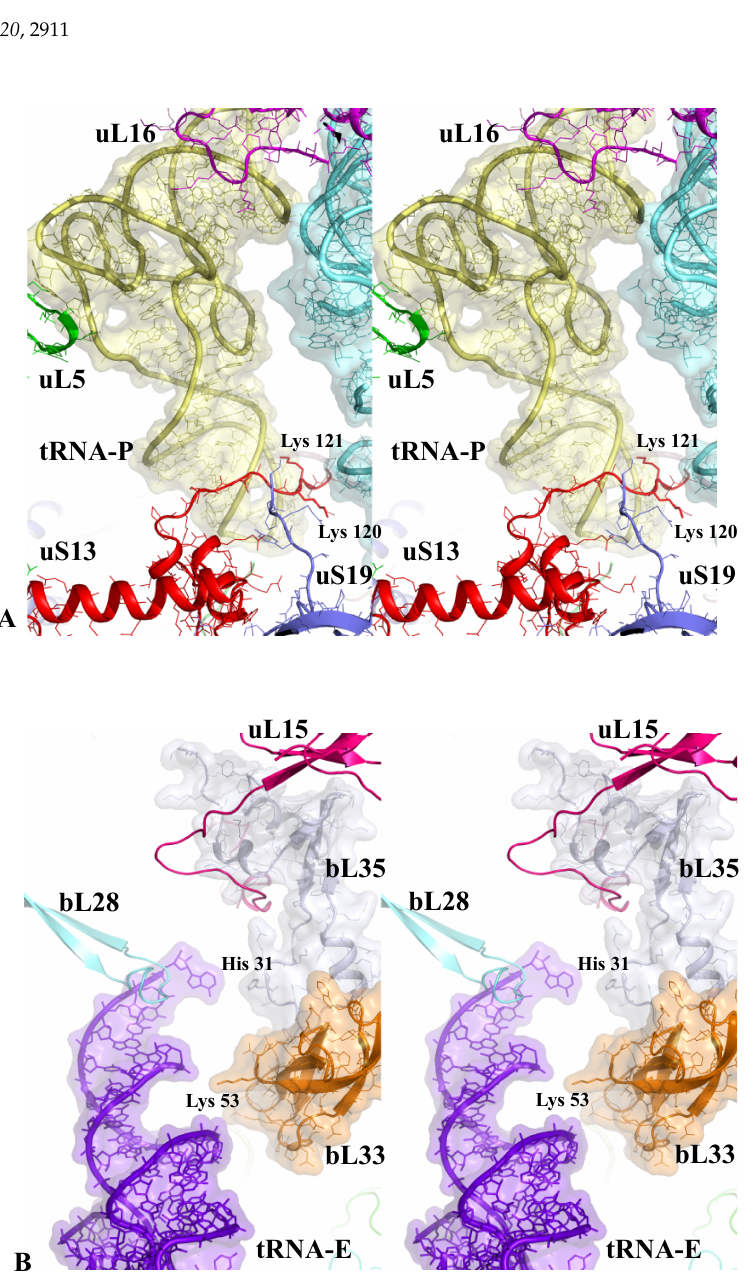
Figure 2. Sensing the P- and E-tRNA sites. Stereoviews of the tiny r-protein tRNA interactions in the ( A ) P- and ( B ) E-tRNA sites (pdb_id: 4y4p).